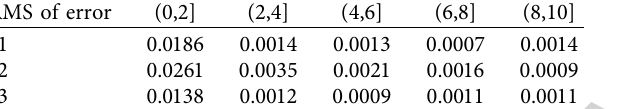
Table 3: RMS values of errors by